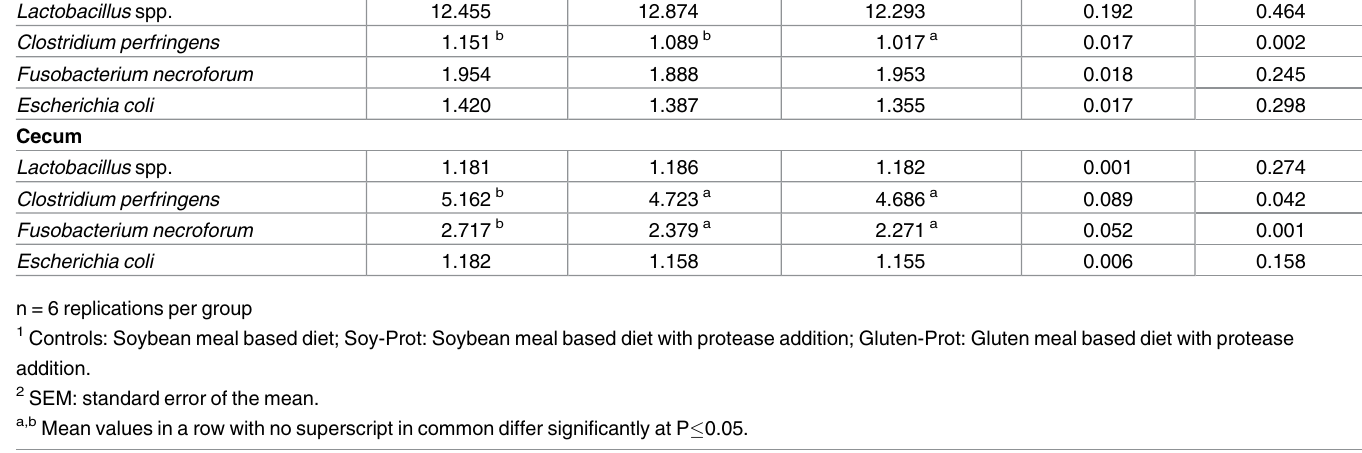
(Table 9). No morphologic lesions or any inflammatory responses were found in the examined intestinal parts of both cecum and small intestine.